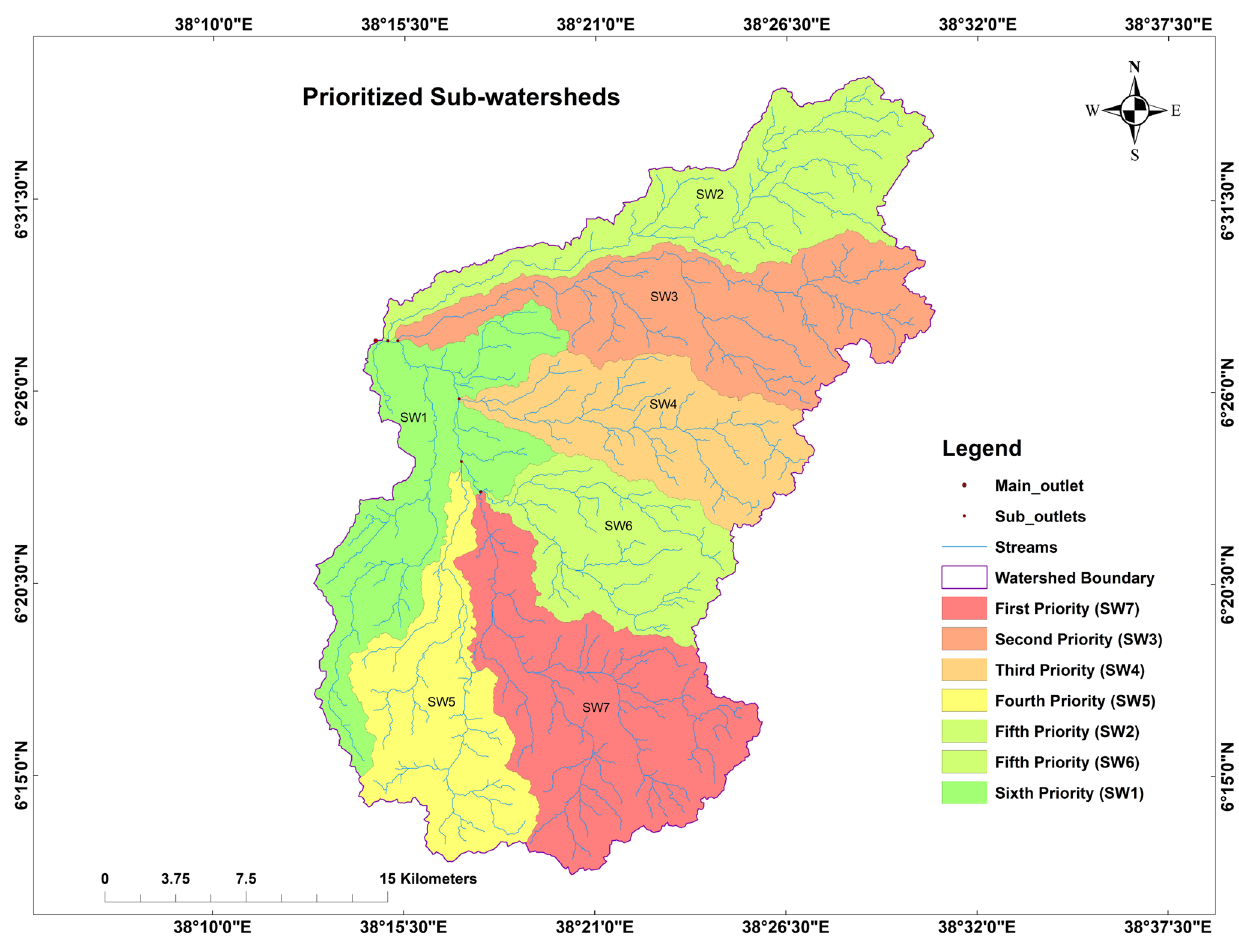
Fig. 6 Map of prioritized sub-watersheds through morphometric